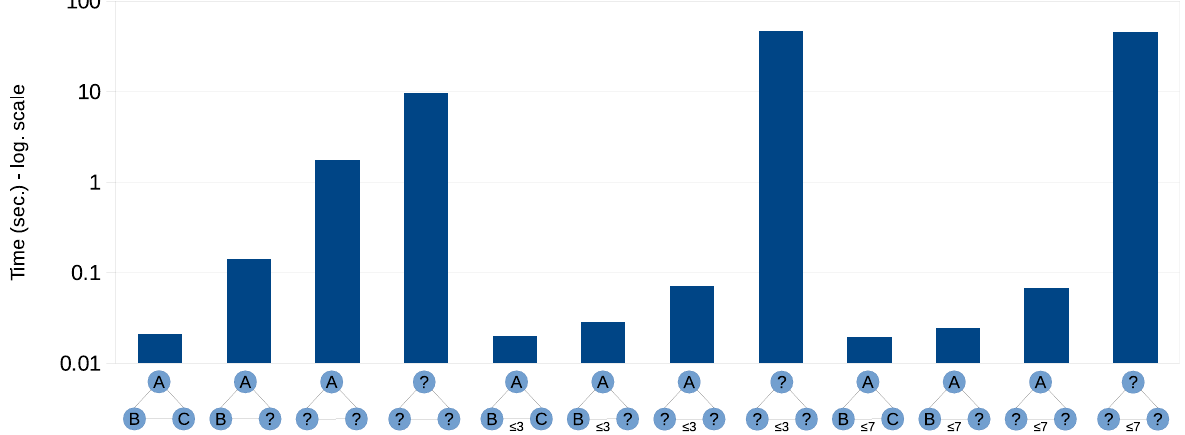
Figure 9. Feed forward loop with wildcards running time on Mus musculus with 512 labels.